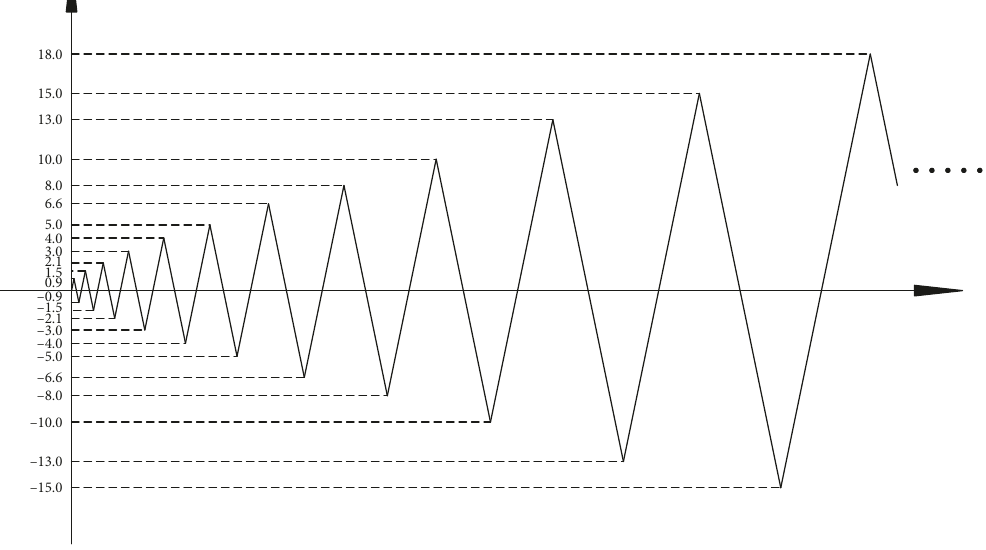
Figure 4: Loading system for displacement